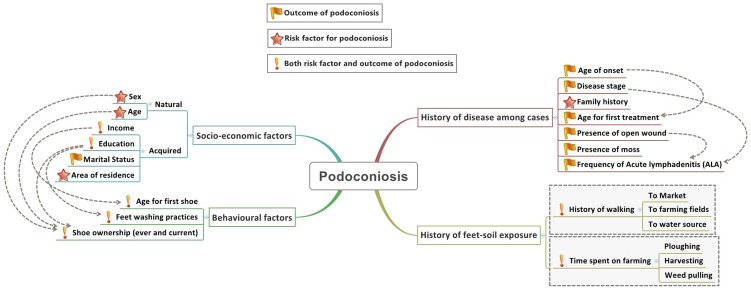
Conceptual framework describing the potential relationships between individual-level correlates and podoconiosis.